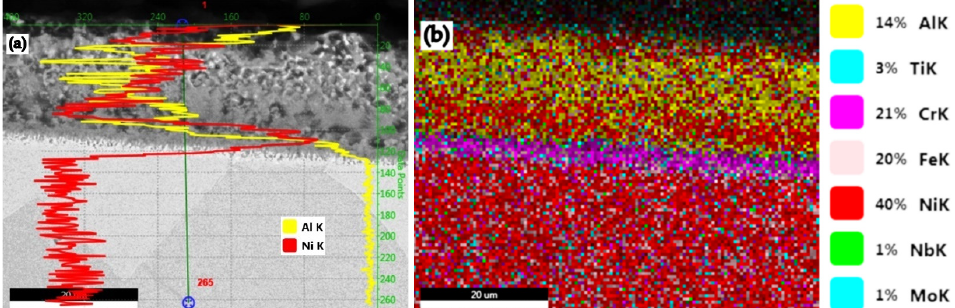
Figure 11. Al and Ni profile plot for pack aluminized IN 718 superalloy (900 °C/5 h) in a pack aluminizing mixture (49 wt.% Al + 49 wt.% Fe + 2 wt.% NH 4 Cl) ( a ); the main alloying elements distribution ( b ).